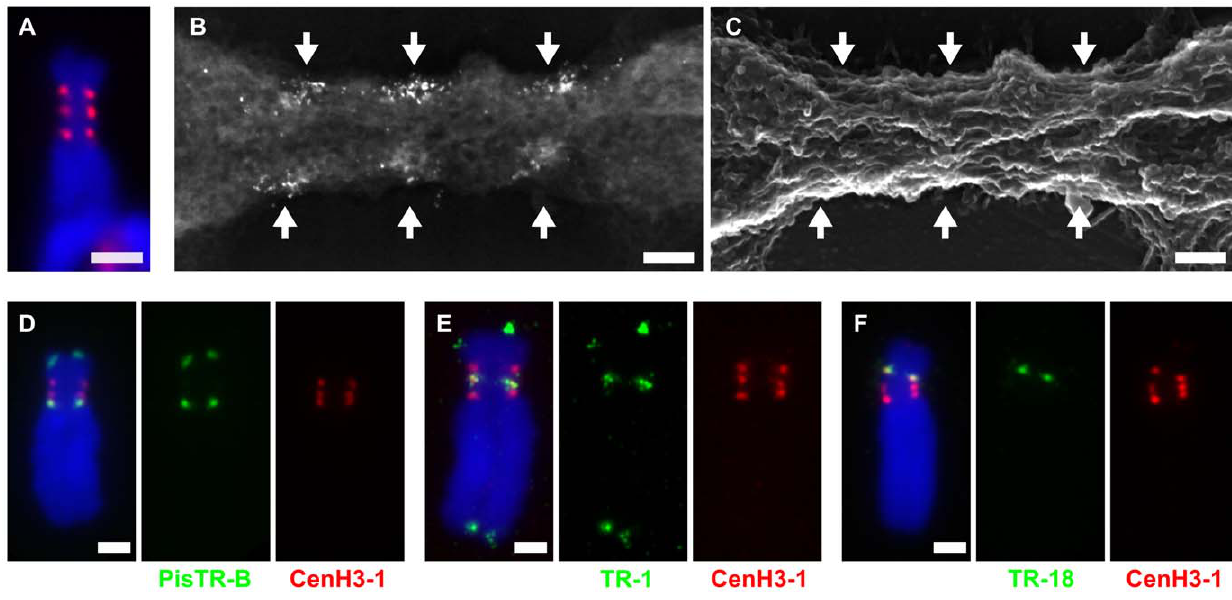
Figure 4. Organization and DNA sequence composition of CenH3-containing domains in chromosome 3. A–B: Primary constriction of chromosome 3 contains three functional centromere domains as defined by the presence of CenH3-1. Correlative fluorescence and scanning electron microscopy images of the same chromosome using FluoroNanogold showed that the three domains recognized with fluorescence (A, red signals) are composed of multiple foci from markers (bright spots) near the surface of the primary constriction (B, backscattered electron micrograph). C: Secondary electron micrograph image of the same chromosome. The primary constriction exhibits few chromomeres and a typical longitudinal orientation of fibrillar substructures, to which the CenH3 domains roughly correspond. The arrows mark the CenH3-1 containing regions. D–F: Detection of three different families of satellite DNA by FISH (green) combined with immunodection of CenH3-1 (red). Each of the functional centromere domains is composed of different family of satellite DNA; the domain closest to the long arm is composed of PisTR-B (D), the middle one of TR-1 (E) and the one closest to the short arm of TR-18 (F). Chromosomes were counterstained with DAPI (blue). Bar=2 m m (A and D–F) or 0.2 m m